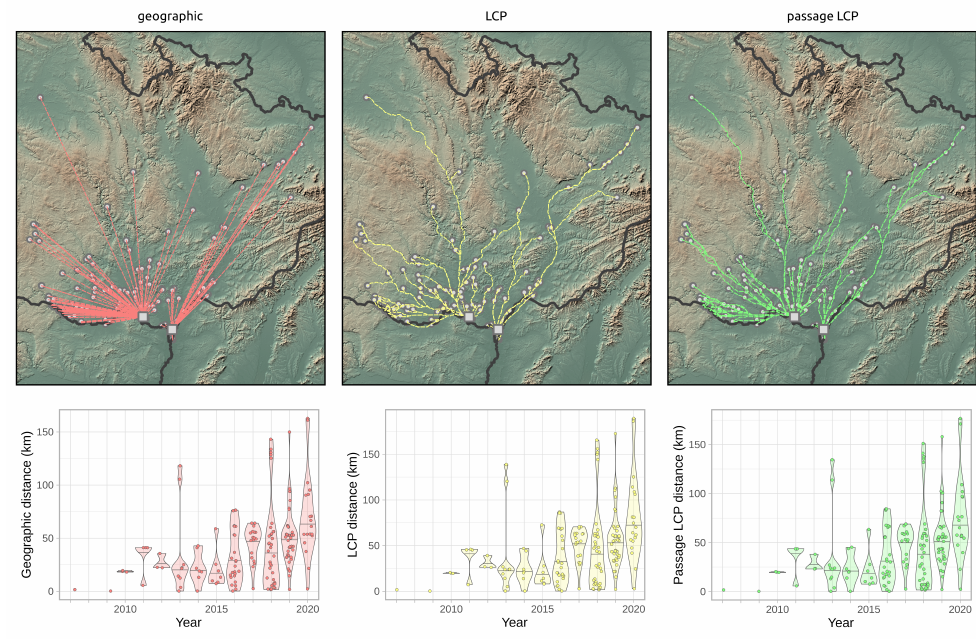
Figure 3. Paths of R. nitidula spread calculated with three methods for estimating distance (geo- graphic, LCP, and passage LCP), and the distribution and median of their distances from 2007 to 2020. Squares in the maps represent two R. nitidula origin points.